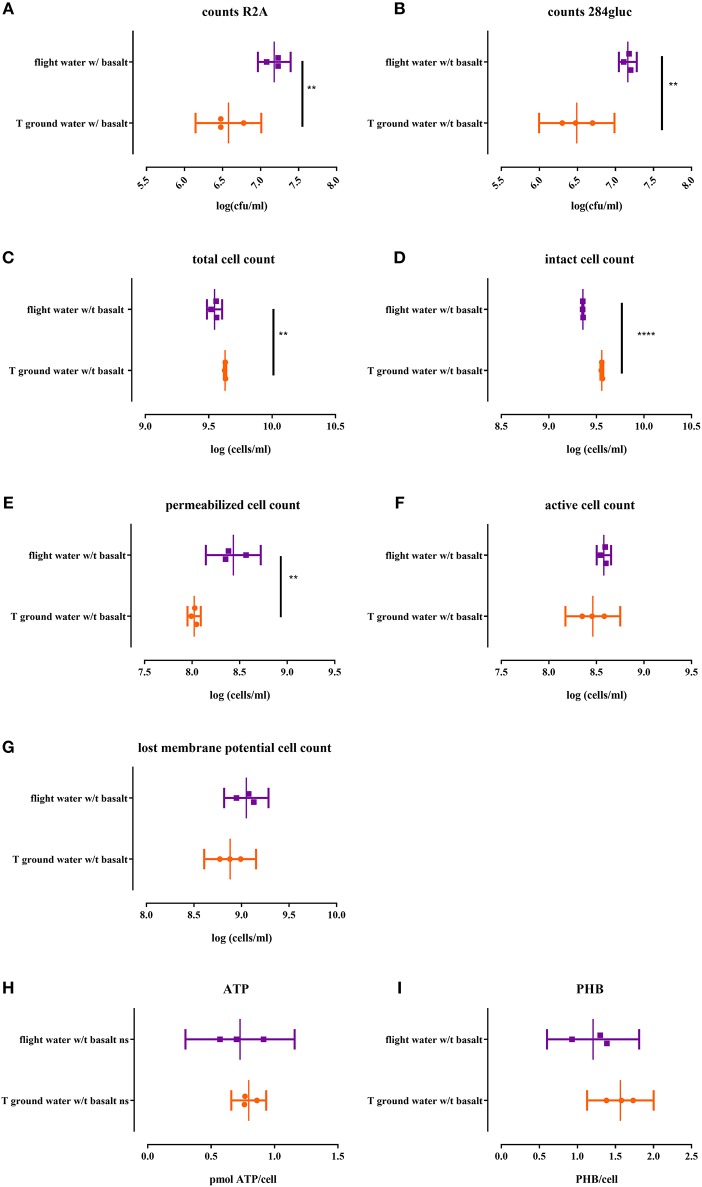
Cell physiology, cultivability ATP and PHB levels of the CH34 biofilm fraction after sonication of both flight and ground samples with basalt, analyzed after the three month flight experiment. All replicates are represented by a dot; the mean is indicated as a line as well as the 95% confidence interval between brackets. For the statistical analysis, one way ANOVA was used with Tukey post testing (alpha = 0.05). Significances are indicated with (*) (with: **p < 0.01 and ****p < 0.0001). P-values as well as significance are also reported in Supplementary Table S2. Samples were plated on R2A (A) and 284 MM agar (B) to determine cultivability of CH34 biofilm cells. The total cells number (SG) (C) as well as the number of intact cells (SGPI) (D), permeabilizated (SGPI) (E), active (cFDA) (G) and cells which have lost their membrane potential [DIBAC4(3)] (F) were measured. ATP (H) and PHB (I) content of the cells was also measured.